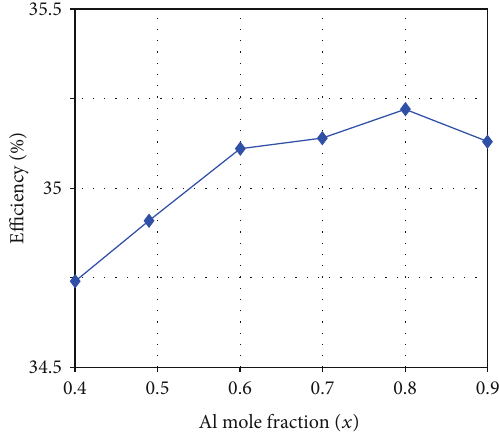
Figure 3: Cell e ffi ciency vs. top window layer thickness.